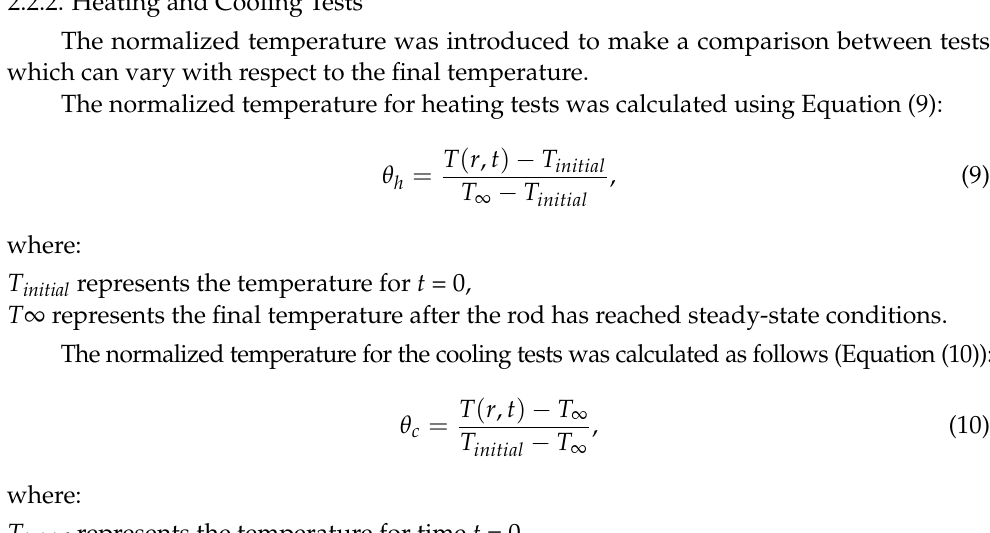
Figure 2. The location of thermocouples in the sample.